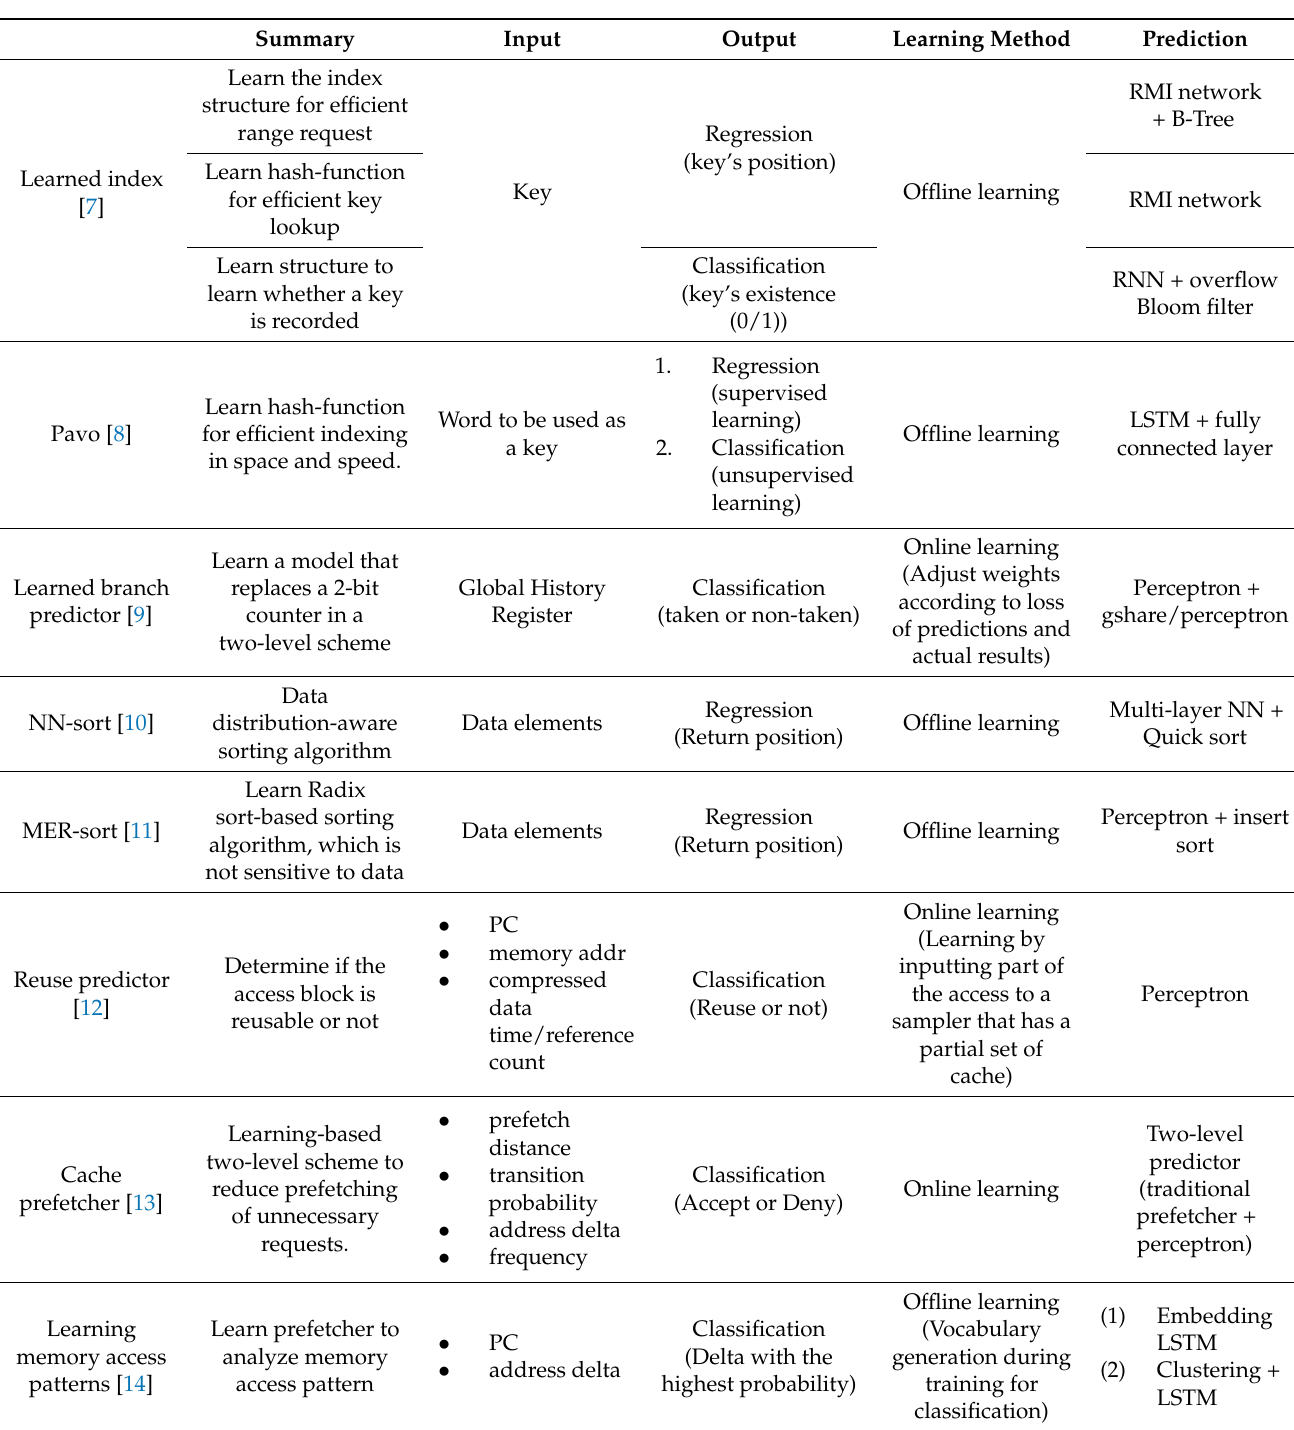
Table 4. Design Summary of the Reviewed